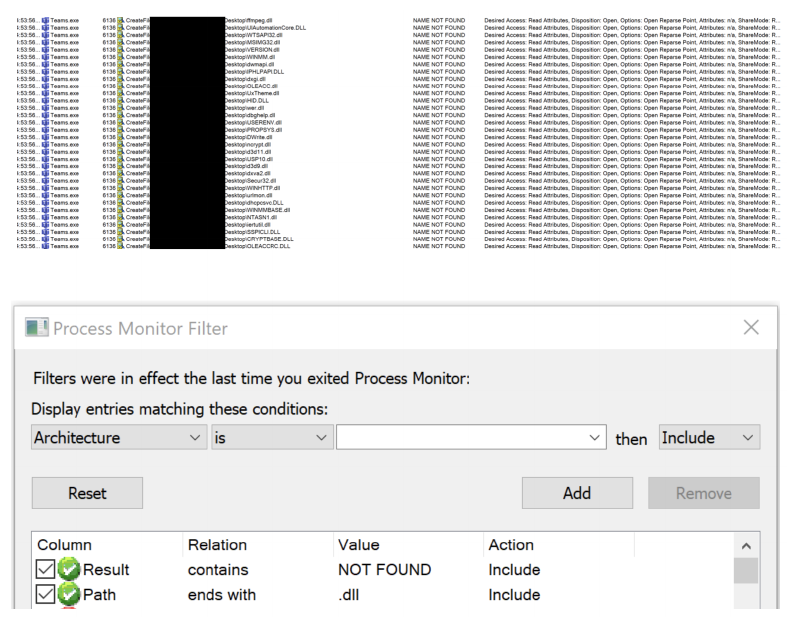
Figure 3. Using Process Explorer to find hijackable